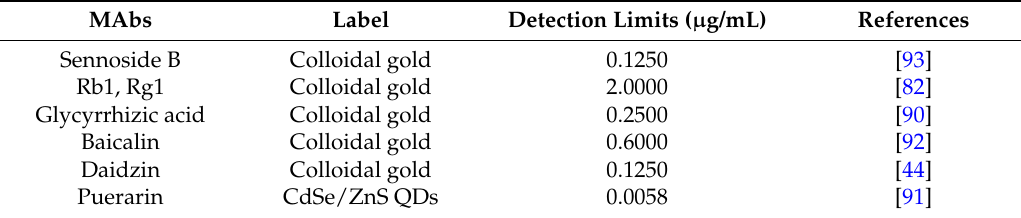
Table 4. The detection limits of established immunochromatographic assay using anti-MPNP MAbs.